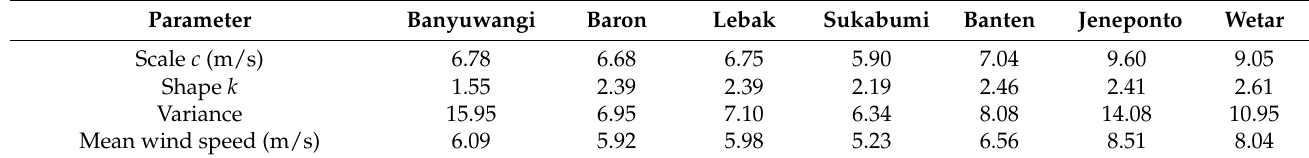
Figure 6. Wind speed distribution for Banyuwangi, Wetar, and Jeneponto. Differences in wind distribution in the rainy and dry seasons were supplementary to the main aims of the study. The average wind speeds in the rainy and dry seasons are discussed in Section 3.1, and the wind characteristics (i.e., wind speed distributions in rainy and dry seasons) of the proposed regions were discussed in the current section. The